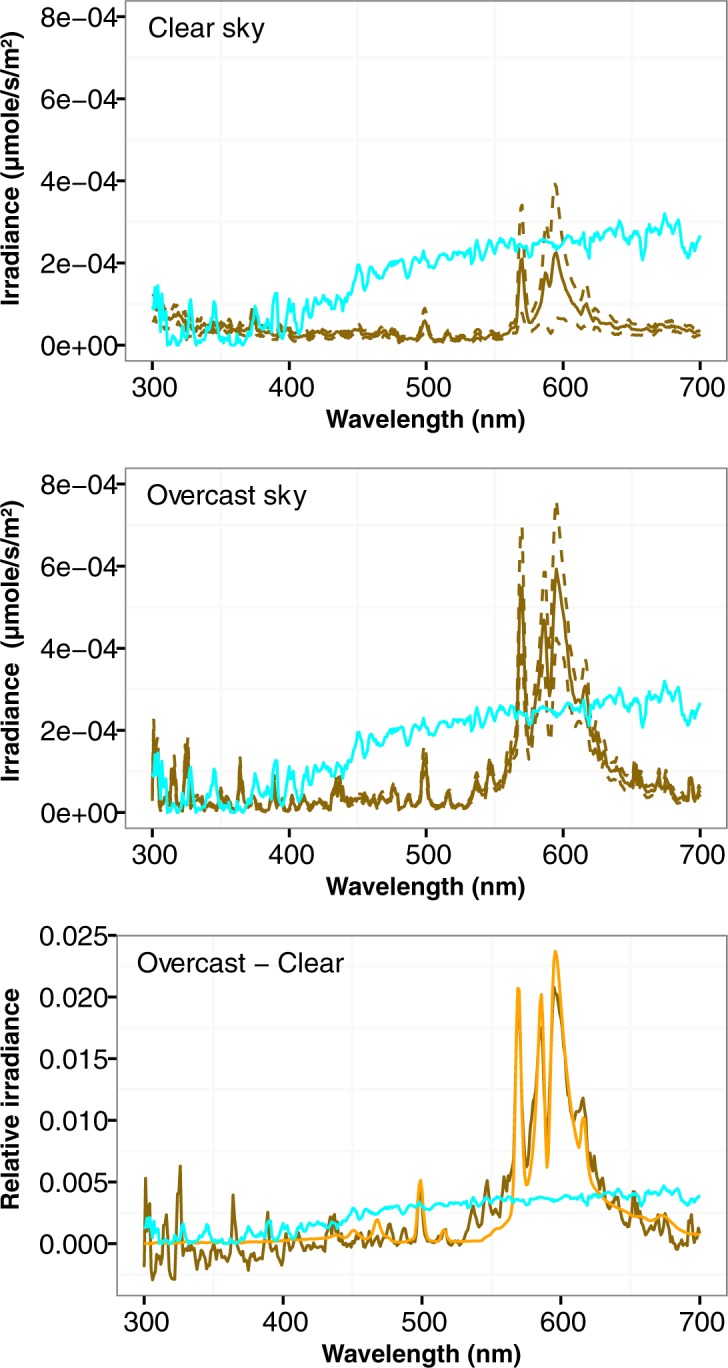
Effect of cloud cover on nocturnal light intensity (Up) Nocturnal downward spectral irradiance as measured under a clear sky and above the water surface of urban and peri-urban ponds. The brown solid line represents the mean and the dotted brown line the standard error. (Middle) Nocturnal downward spectral irradiance as measured under an overcast sky and above the water surface of urban and peri-urban ponds. The brown solid line represents the mean and the dotted brown line the standard error. (Bottom). Illustration of the increase of downward irradiance by cloud cover in the emission range of artificial lighting. The brown line represents the difference in irradiance between an overcast and a clear night, the orange line the emission the spectrum of a high pressure lamp. Both spectra have been standardized so that their shape can be visually compared. For all panels, the cyan line represents the downward irradiance of a clear sky during full Moon on 20/07/16 at 1:15 in a rural area (0.604°W, 47.684°N).